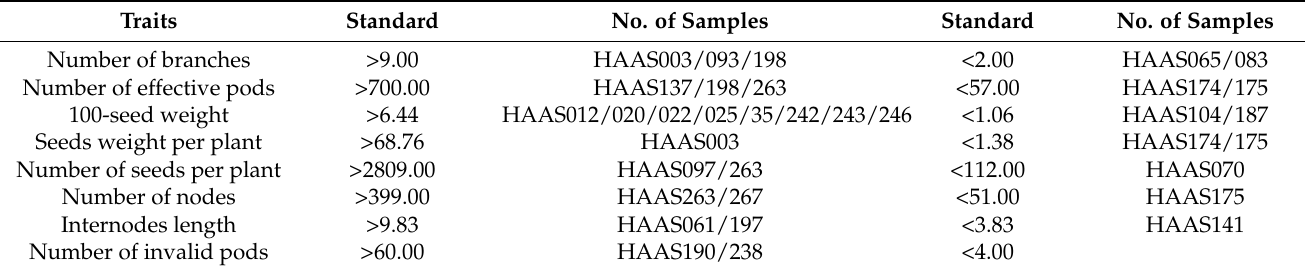
Table 9. Screening of specific samples based on standard values of eight agronomic traits in 242 wild soybean samples in this